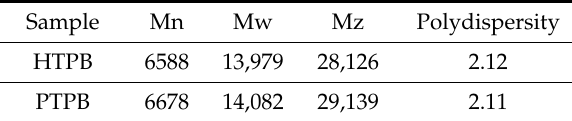
Figure 3. GPC curves for HTPB and PTPB. Table 2. Parameters of prepolymer HTPB and PTPB.